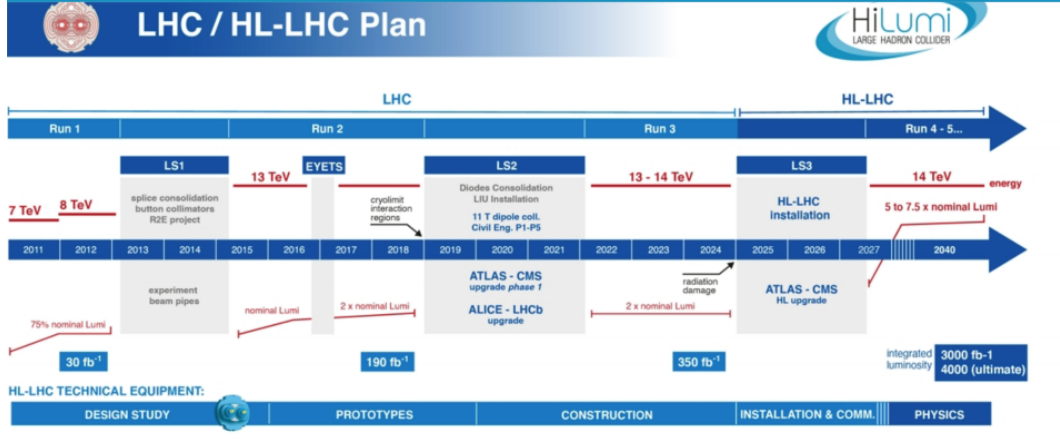
Figure 1: LHC upgrade programme [ 13 ]